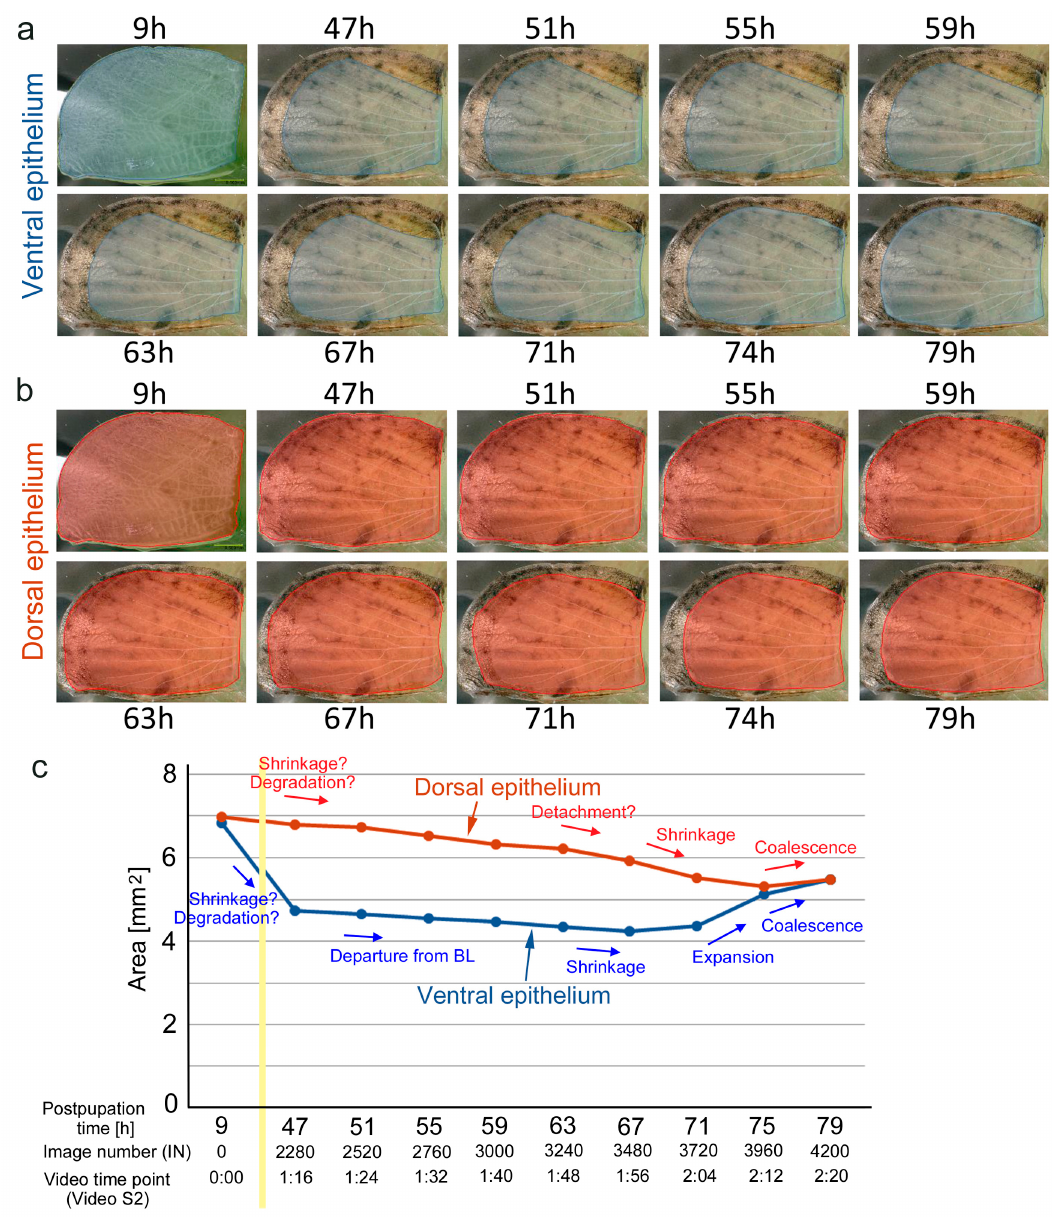
Figure 4. Time-dependent changes in the epithelial area in the developing pupal forewing. ( a ) Ventral epithelium. The areas measured are shown in blue. ( b ) Dorsal epithelium. The areas measured are shown in reddish brown. ( c ) Quantitative area changes. The events observed in the outer margin of the wings are indicated in arrows and with brief descriptions. Peripheral changes at the costal margin and hind (inner) margin are earlier than those at the outer margin. The vertical yellow bar indicates a time gap. Image numbers and time points in Video S2 are also indicated.